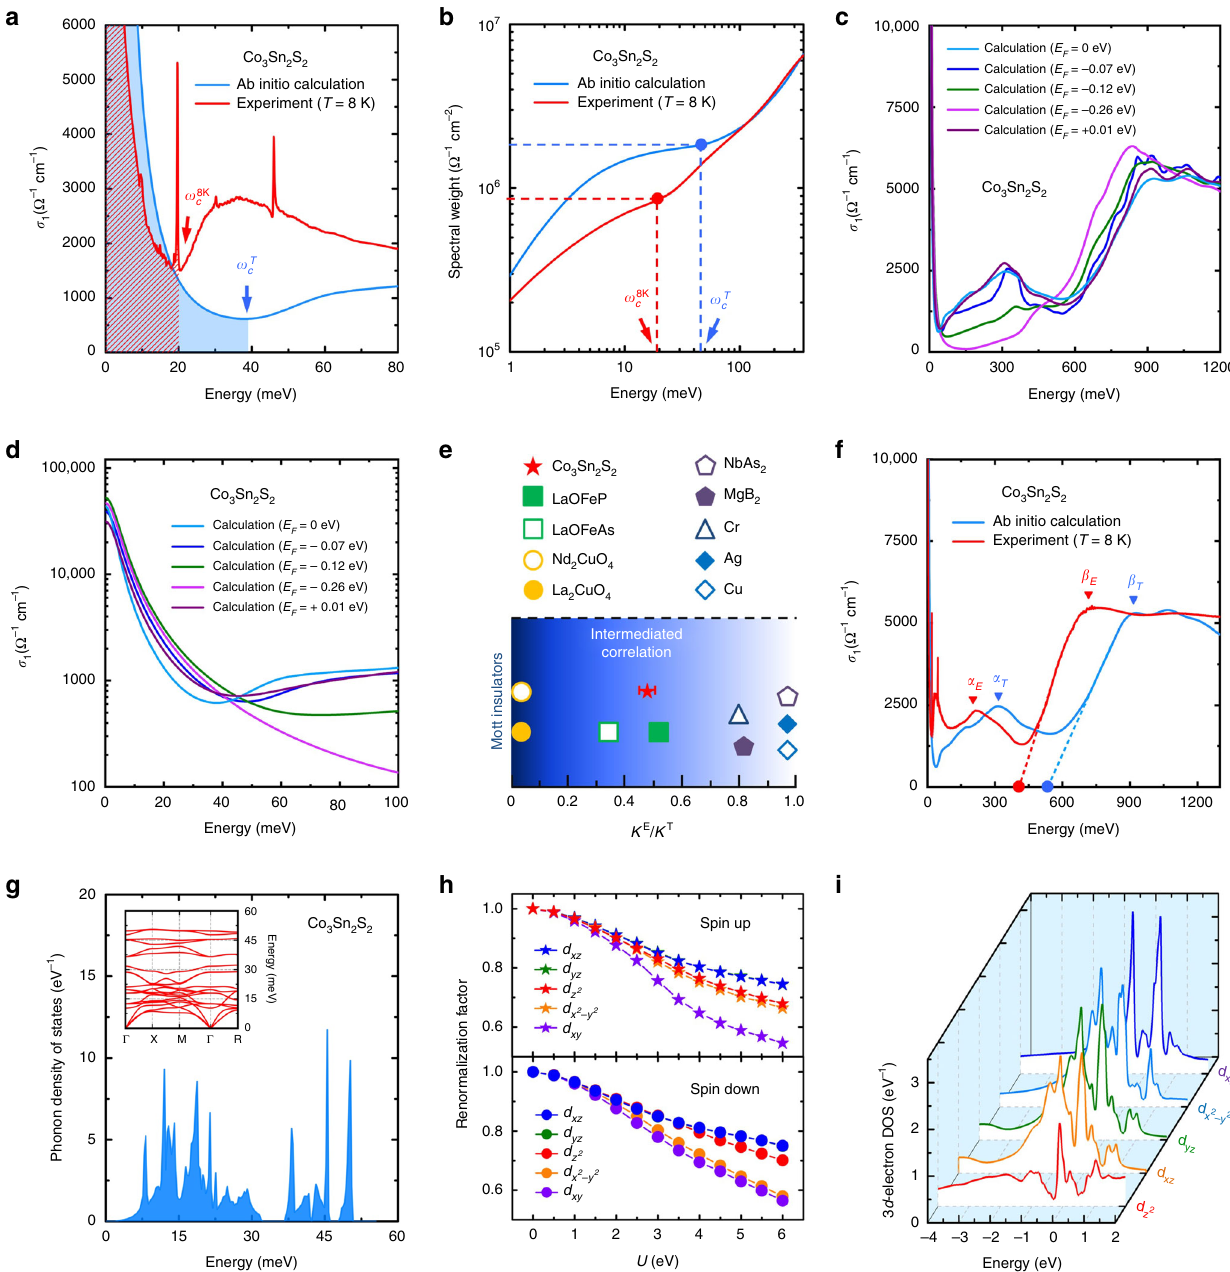
( ω ) at temperature T = 8 K and Fig. 2 Electronic correlation effects in ferromagnetic Co 3 Sn 2 S 2 . a Real parts of the experimental optical conductivity σ E 1 the theoretical optical conductivity σ T ( ω ) obtained by single-particle ab initio calculations in the FM ground state. The cutoff energies ( ω 8 K and ω T ) for 1 c c integrating the Drude components are chosen as the energy positions where the σ E ( ω , T = 8 K) and the σ T ( ω ) reach the minimum, respectively. b Spectral 1 1 weights of the σ E ( ω , T = 8 K) at ω 8 K and the σ T ( ω ) at ω T . c , Theoretical σ T ( ω ) calculated with the Fermi energies E F = 0, − 0.07, − 0.12, − 0.26 and 1 1 1 c c + 0.01 eV. d Low-energy parts of the theoretical σ T ( ω ) calculated with the different Fermi energies. e Ratio of the experimental kinetic energy at T = 8 K 1 = K T for Co K E and K T for other quantum materials can and theoretical kinetic energy K E 3 Sn 2 S 2 and several other quantum materials. The values of the 8 K be gained from the following references: LaOFeP (Ref. 68 ), LaOFeAs (Ref. 70 ), topological nodal-line semimetal NbAs 2 (Ref. 99 ), paramagnetic Cr (Ref. 100 ), Ag (Ref. 101 ), Cu (Ref. 101 ), MgB 2 (Ref. 79 ), Nd 2 CuO 4 , and La 2 CuO 4 (Ref. 80 ). The error bar on the Co 3 Sn 2 S 2 data is based on the uncertainty in the experimental cutoff energy ω c . f Two interband-transition-induced peaks α E and β E in the σ E ( ω , T = 8 K) and the two peaks α T and β T in the σ T ( ω ). The red 1 1 and blue arrows indicate the left sides of the experimental peak β E and the theoretical peak β T , respectively. The red and blue dashed lines are guides for eyes showing the slopes of the left sides of the peaks β E and β T , respectively. The slope of the left side of the experimental peak β E is larger than that of the theoretical peak β T . The ratio between the slopes of the left sides of the peaks β T and β E is ~0.74. The energy intercepts of the red and dashed lines at σ ω ) = 0 are labeled with the red and blue dots, respectively. g Phonon density of states obtained by ab initio calculations. The inset depicts the calculated 1 ( phonon dispersions. The phonon DOS and the phonon dispersions are cut off at ~50.8 meV. h Coulomb-energy dependences of the electronic-bandwidth renormalization factors of the spin-up and spin-down Co 3 d orbitals. The renormalization factors of the d xz and d yz orbitals are quite close to each other. i Energy distributions of the 3 d -electron density of states obtained by many-body